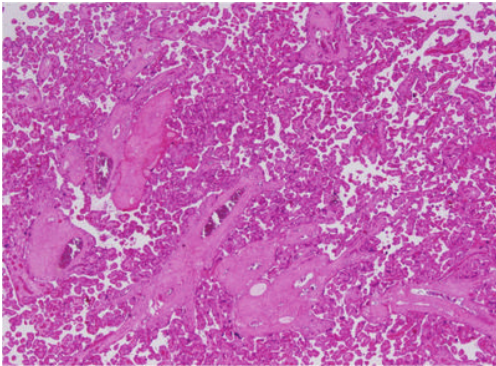
Figure 1: Findings compatible with the third trimester: small villi with prominent syncytiotrophoblasts, areas with thinned syncy- tiotrophoblast adjacent to blood vessels (vasculosyncytial mem- branes), and much less apparent cytotrophoblasts. (HE ×